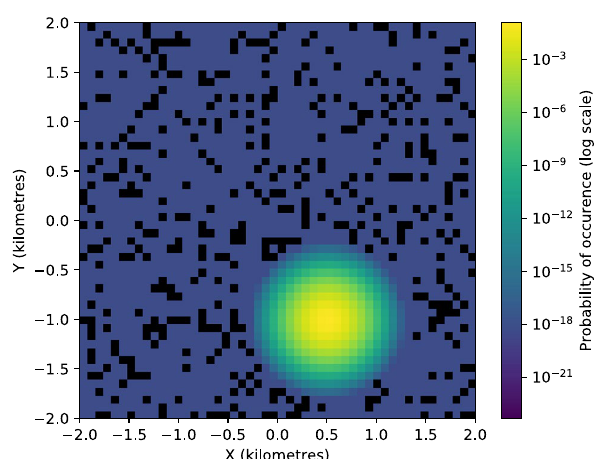
Figure 5. Steady-state probability distribution computed for GH1Br using harmonic potential that scales as x 2 . For this case, we placed an additional hypothetical roost site at ( X at the origin. The probability distribution is centred around the centroid of the two roosts. Also, note that the probability is more evenly spread in the region where it is not close to 0 (represented by the yellow